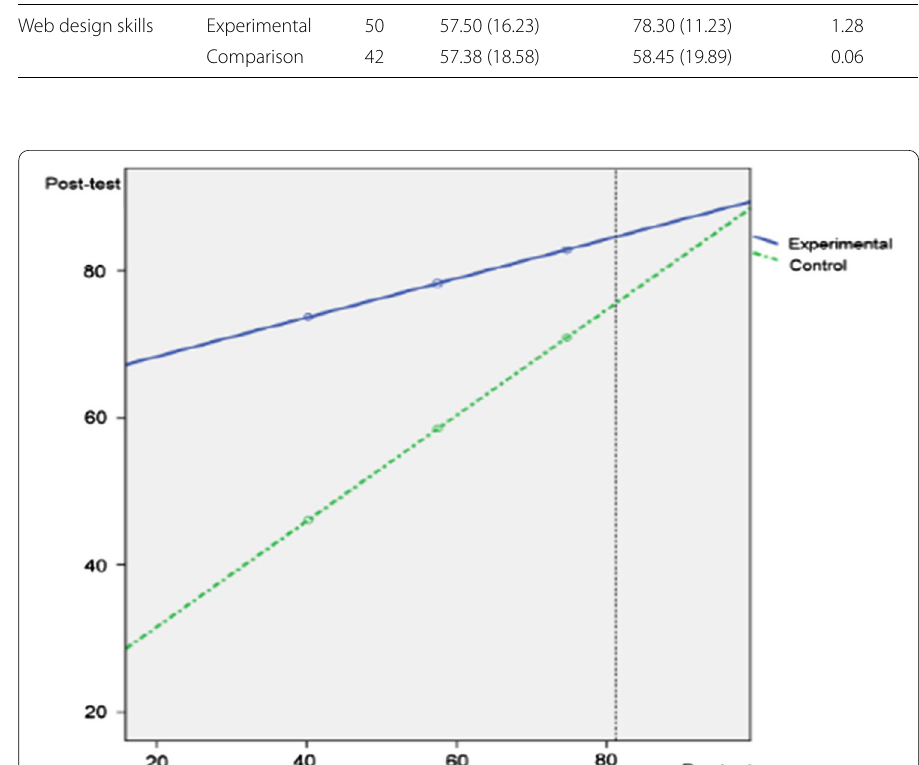
Fig. 1 The regression lines of the two groups in the web design skills